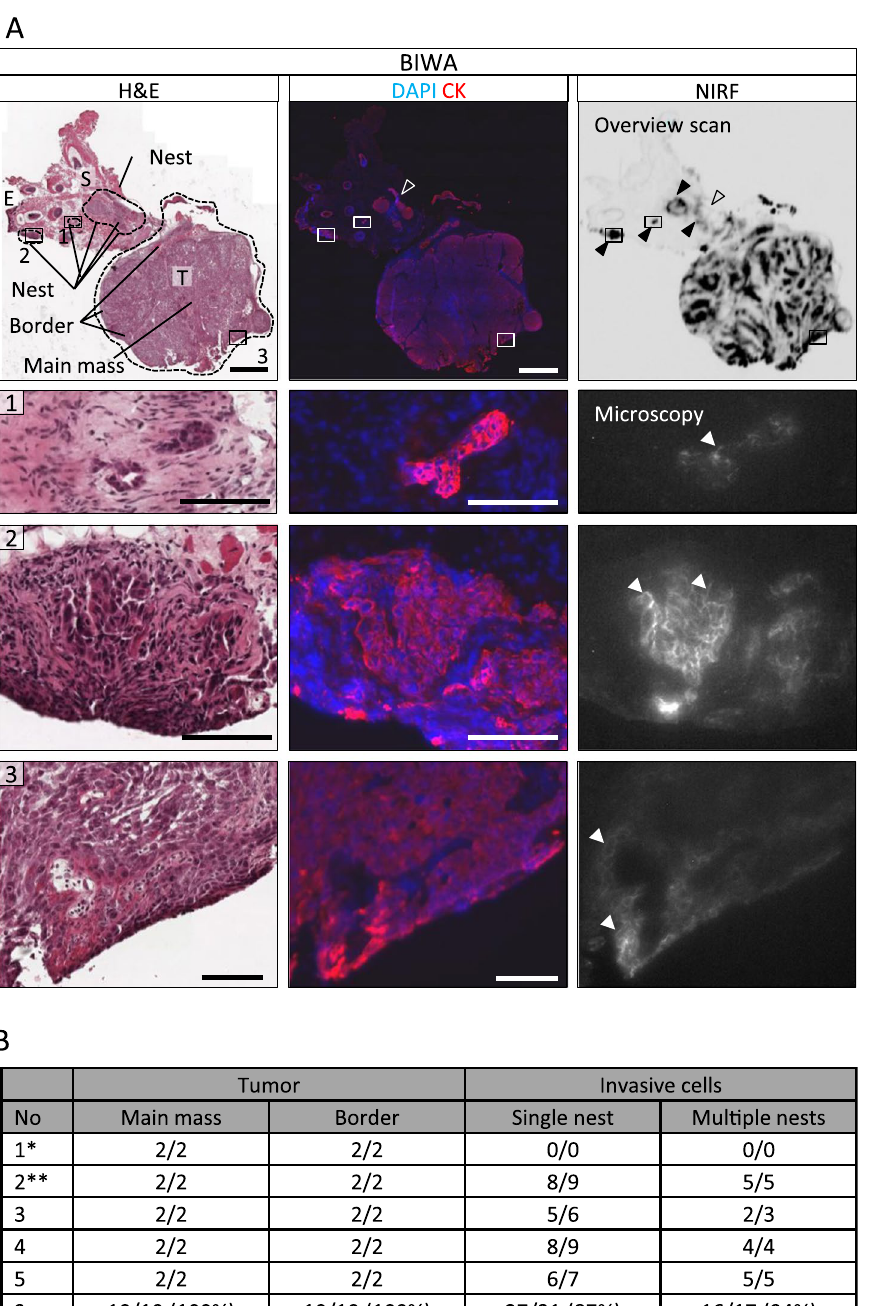
Figure 4. Detection of invasive tumor regions by dual-labeled BIWA 3 days after systemic administration. ( A ) Central, serial sections of a tumor (H&E staining, CK staining and NIRF signal). Images show invasive tumor islands (1, 2, dotted line) adjacent to the main tumor (3, dotted line). Tumor (T), normal epithelium (E), stroma (S). Black arrowheads indicate fluorescent positive islands, the transparent arrowhead a negative/weakly stained island. White arrowheads highlight membranous staining. Scale bars indicate 1 mm (overview) and 100 µ m (zoom). ( B) Scoring of NIRF signal intensity for tumor core, border and invasive cells including isolated nests and clusters of adjacent islands. Data represent scoring of two sections per tumor in 5 mice. * Example shown in Suppl. Fig. 4, ** Example shown in Fig.